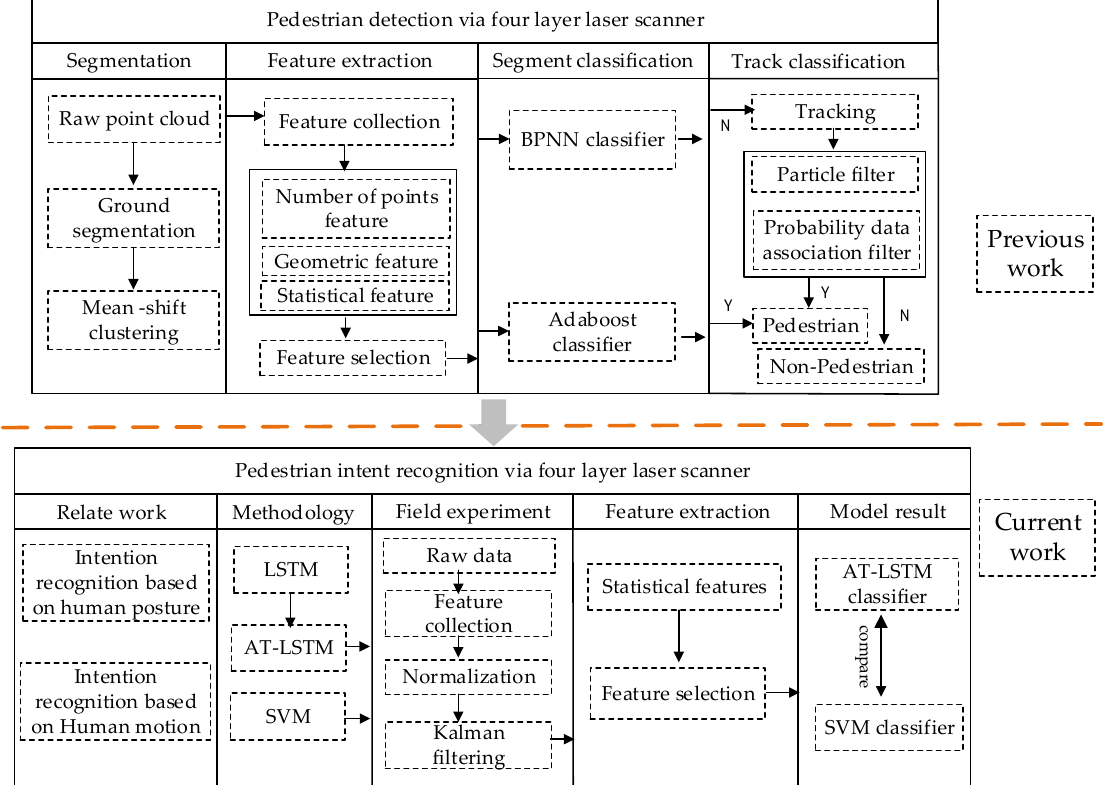
Figure 1. Pedestrian crossing intention recognition framework.